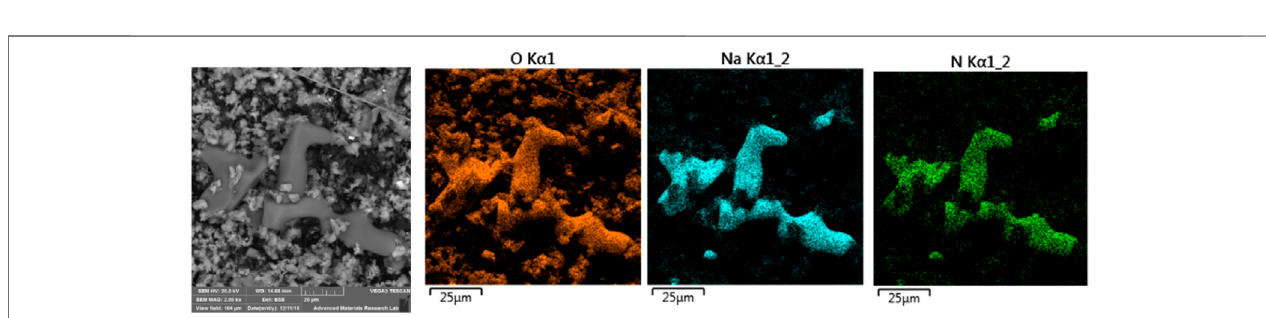
FIGURE 9 | SEM micrograph and elemental maps of fi lter #50.